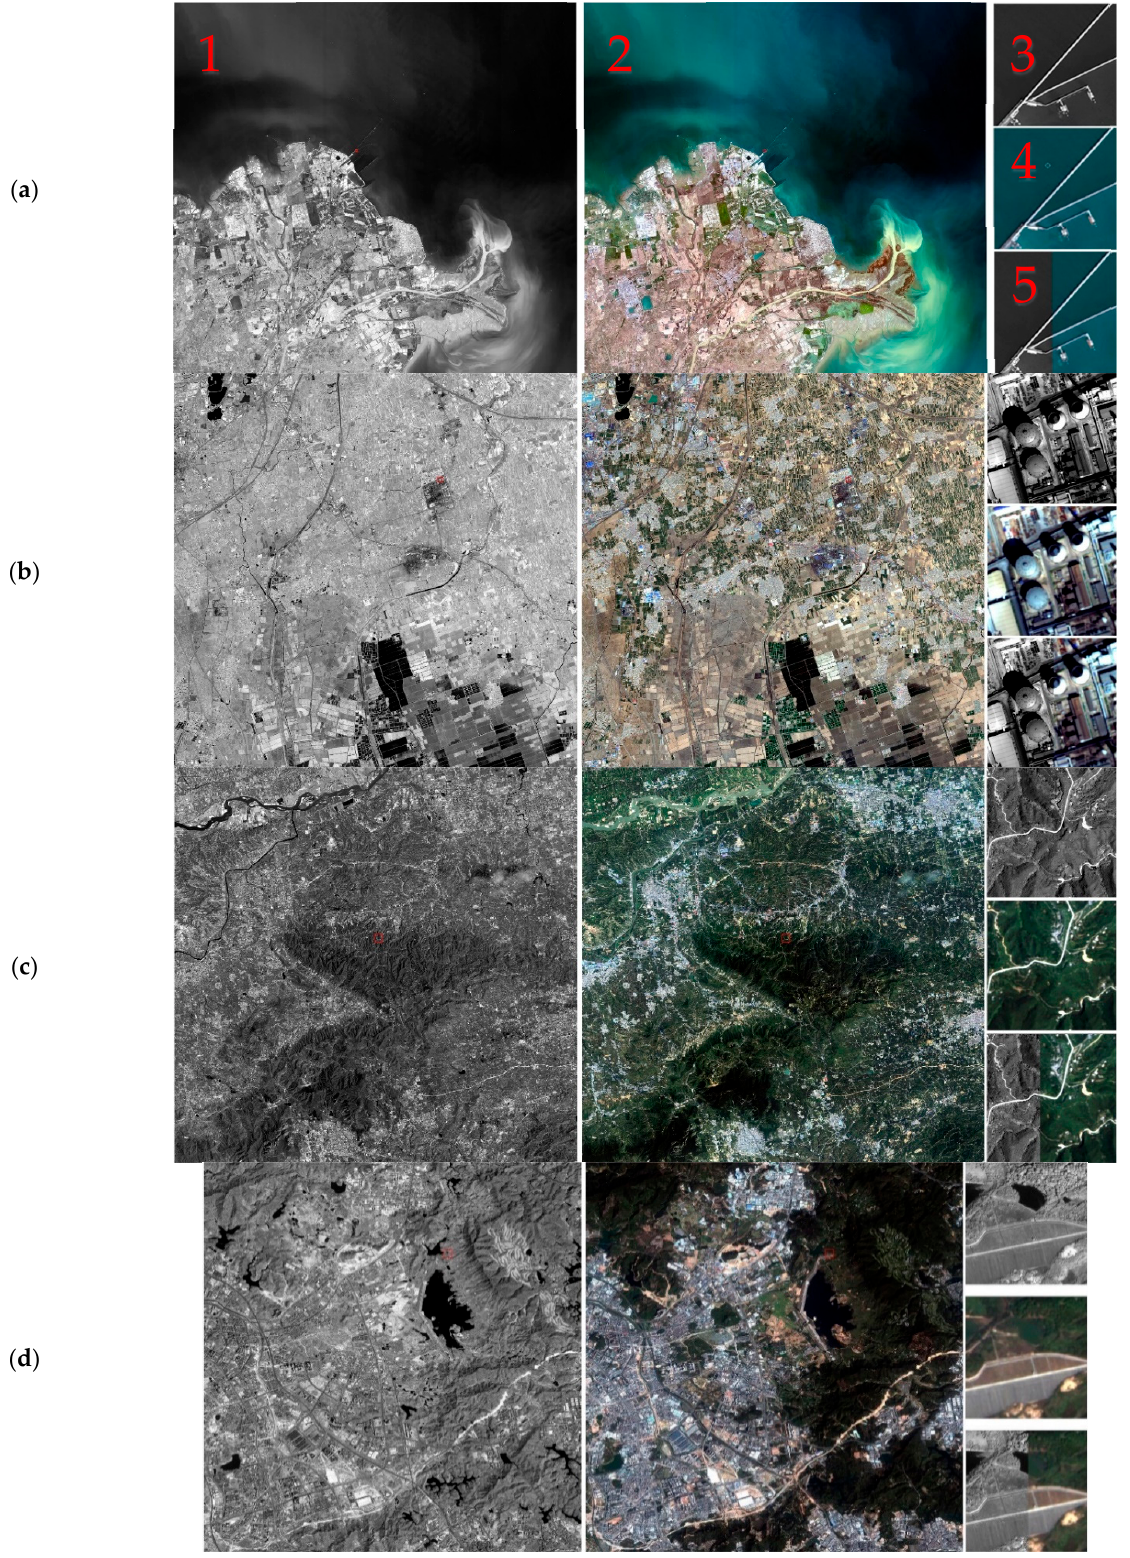
Figure 4. Registered images. ( a ) GF-6, ( b ) GF-7, ( c ) ZY3-02, ( d ) SV-1. (1) is a PAN image, (2) is an MS image up-sampled to PAN scale, (3) shows the details of (1), (4) shows the details of (2), and (5) is a comparison of details. Same in ( b – d ).